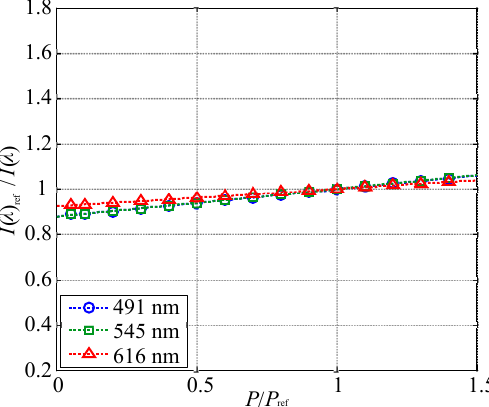
Figure 14. I ( λ ) ref / I ( λ ) as a function of the normalized pressure at T = 293